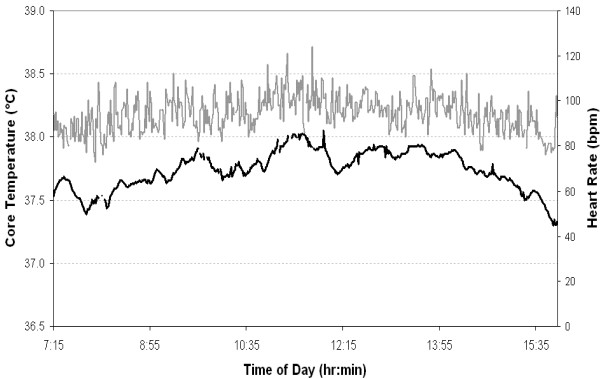
A representative core body temperature (solid black line) and heart rate (solid grey line) response during a shift.